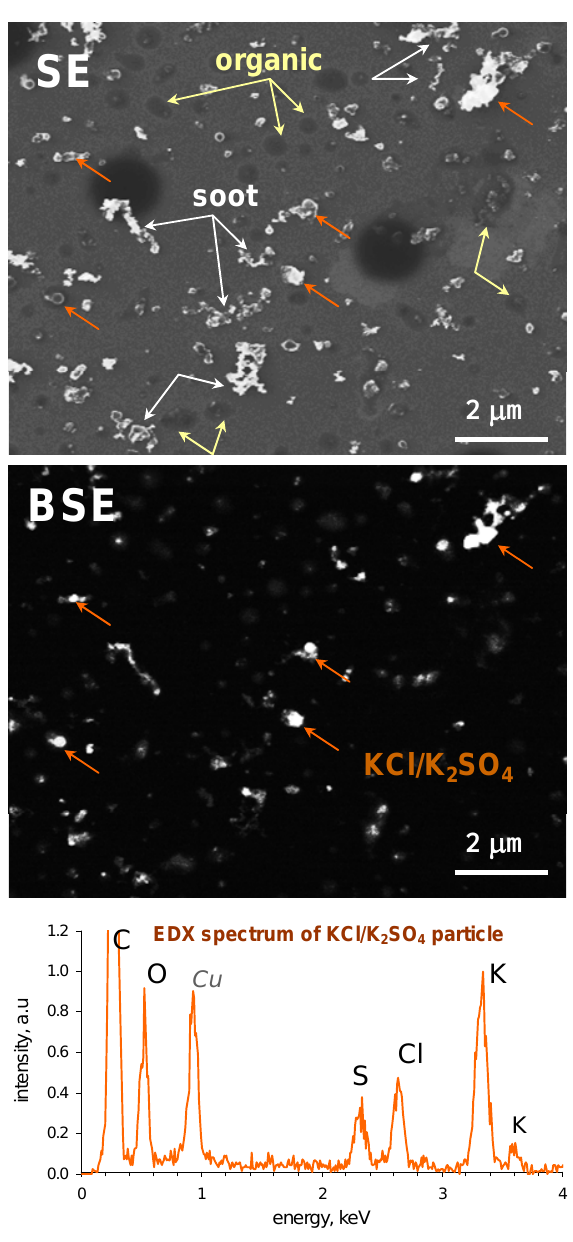
Fig. 7. Secondary electron (SE) image (top panel) and back scattered electron (BSE) microscope image (middle panel) of smoke particles generated from burns of Utah sage/rabbit brush fuel. Typ- ical fractal soot, organic and inorganic particles are seen internally and externally mixed. Carbonaceous soot and organic constituents are invisible in the BSE image, while inorganic constituents are seen as bright spots in the BSE image. Bottom panel: characteristic en- ergy dispersed X-ray (EDX) spectrum of inorganic inclusions indi- cates their mixed KCl/K 2 SO 4 composition. (Cu peak results from a substrate background, C and O peaks are mixed background and sample signals). Samples were collected in the 0.18–0.32µm aero- dynamic diameter size